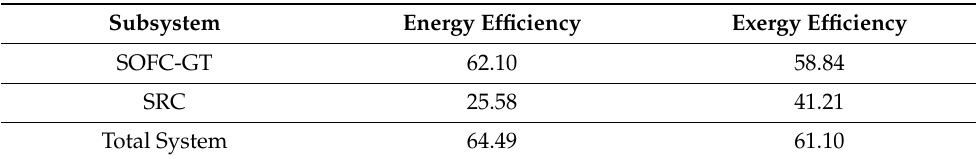
Table 6. Energy and exergy efficiency of the proposed